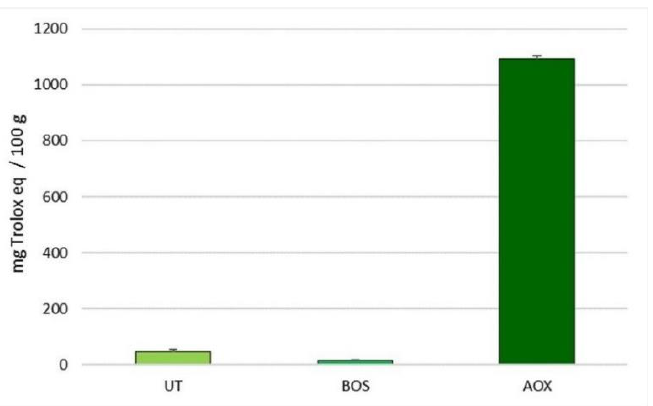
Figure 1. In vitro antioxidant activity of the selected natural extracts measured with biological test KRL (concentration 0.1 g/L). Data are reported as mean ± SEM; n = 3. BOS, B. serrata extract; UT, U. tomentosa and T. parthenium extracts; AOX, antioxidant plant extract mixture.